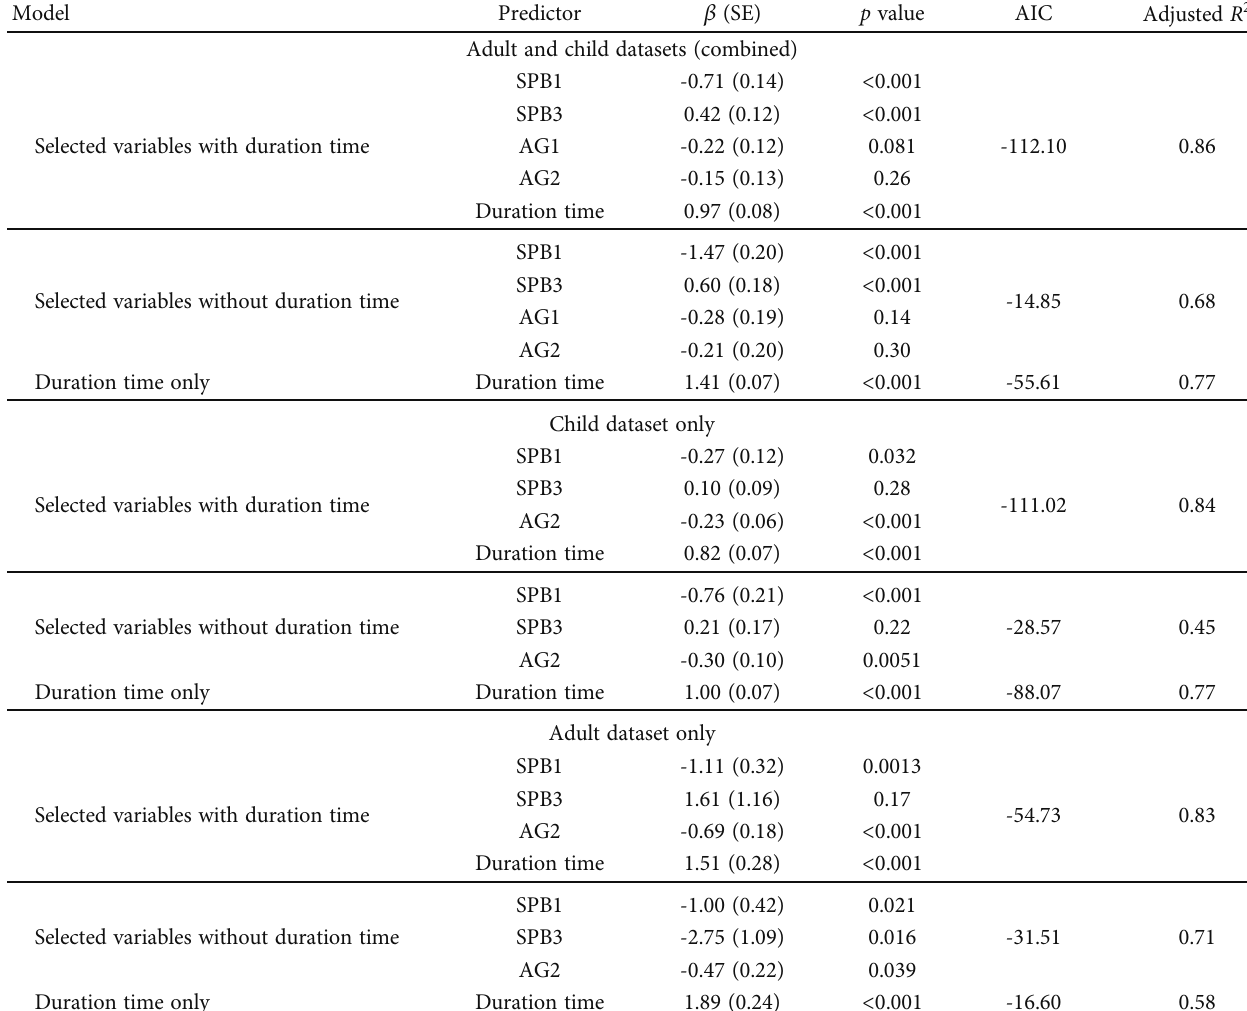
Table 1: Regression modeling results.